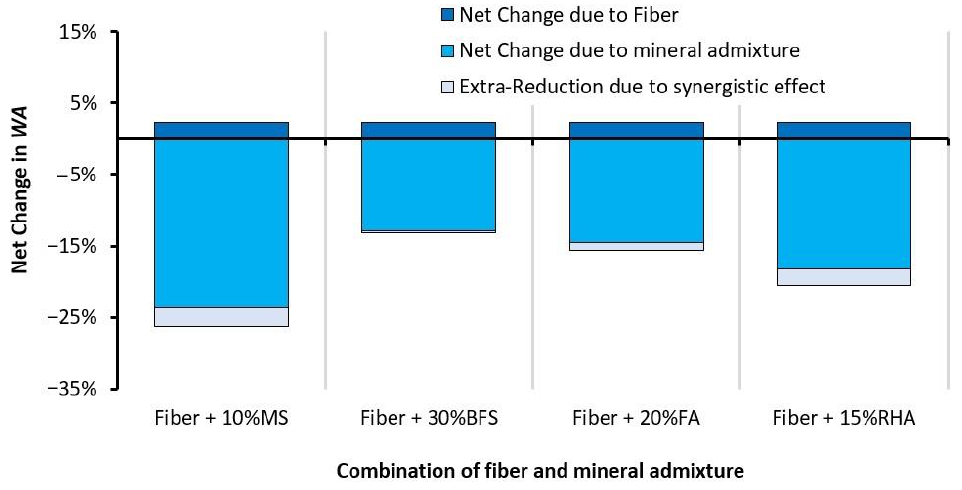
Figure 20. The combined effect of mineral admixtures and fibers on the net change in the WA of RAC.